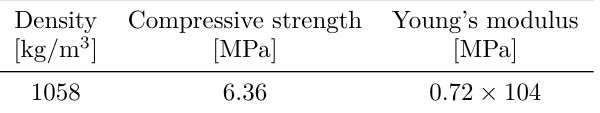
Table 3. Mechanical properties of lightweight concrete (expanded polystyrene